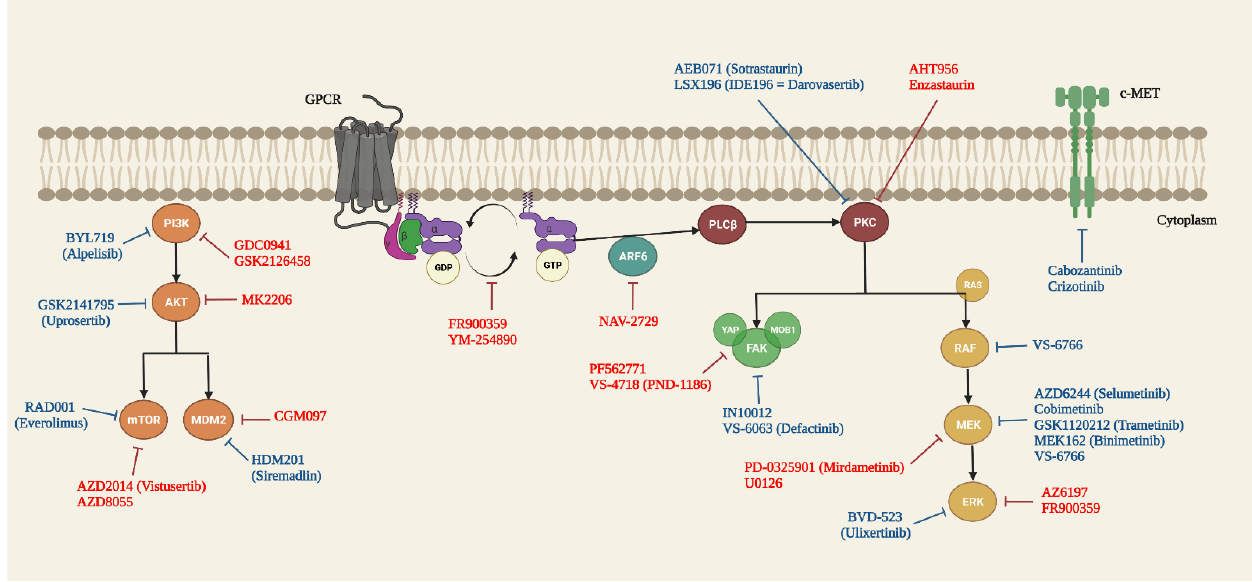
Figure 1. Simplified view of heterotrimeric G protein Gαq/11 and its cellular downstream signalling pathways in UM. Targeted therapies studied only preclinically are shown in red, and those already tested in clinical trials are shown in blue. Created with BioRender.com (accessed on 1 February 2022).